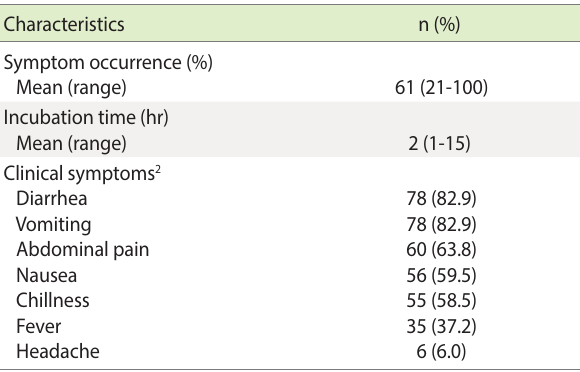
Table 1. Epidemiological characteristics of cases with food poison- ing (n=94) detected by Kudoa septumpunctata in 2015, in Korea 1 Characteristics